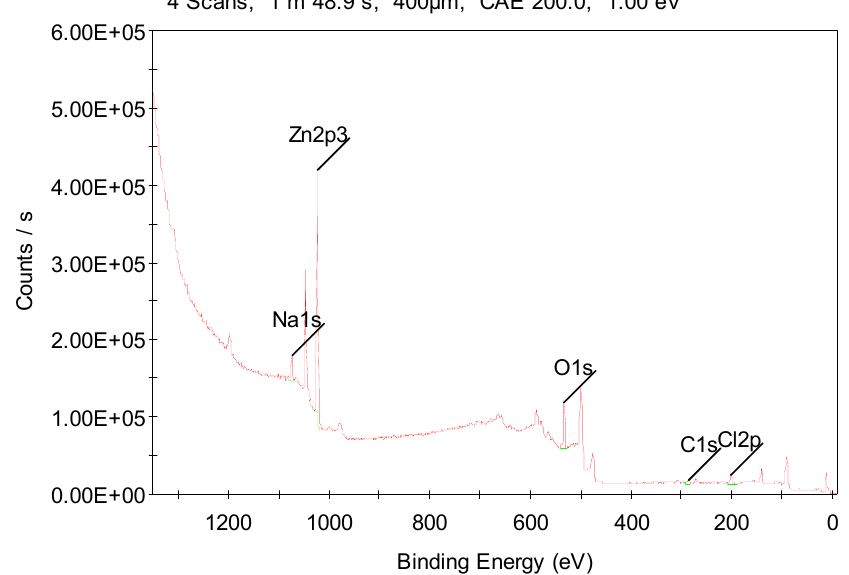
Figure 2. Overview spectrum of 0.5 M ZnO film with 1 eV resolution.